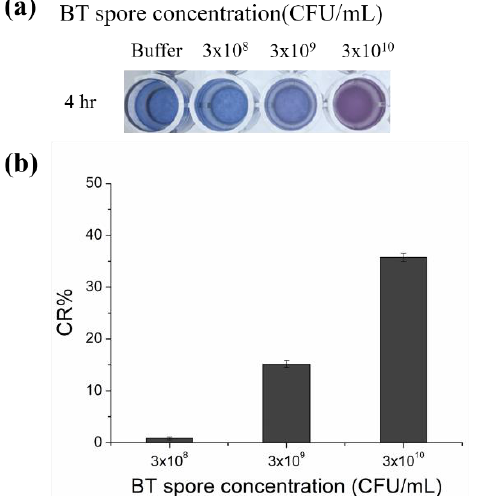
Figure 2. PDA-aptamer liposomes incubated with different concentrations of spore solutions. ( a ) Image of PDA-aptamer liposomes after 4 h of incubation in PBS (pH = 7.5, 5 mM) and spore solutions at different concentrations. ( b ) Color response percentage (CR%) of the PDA-aptamer liposomes after 4 h of incubation in spore solutions of different concentrations. Color response data are presented as the mean ± SD (n = 3).